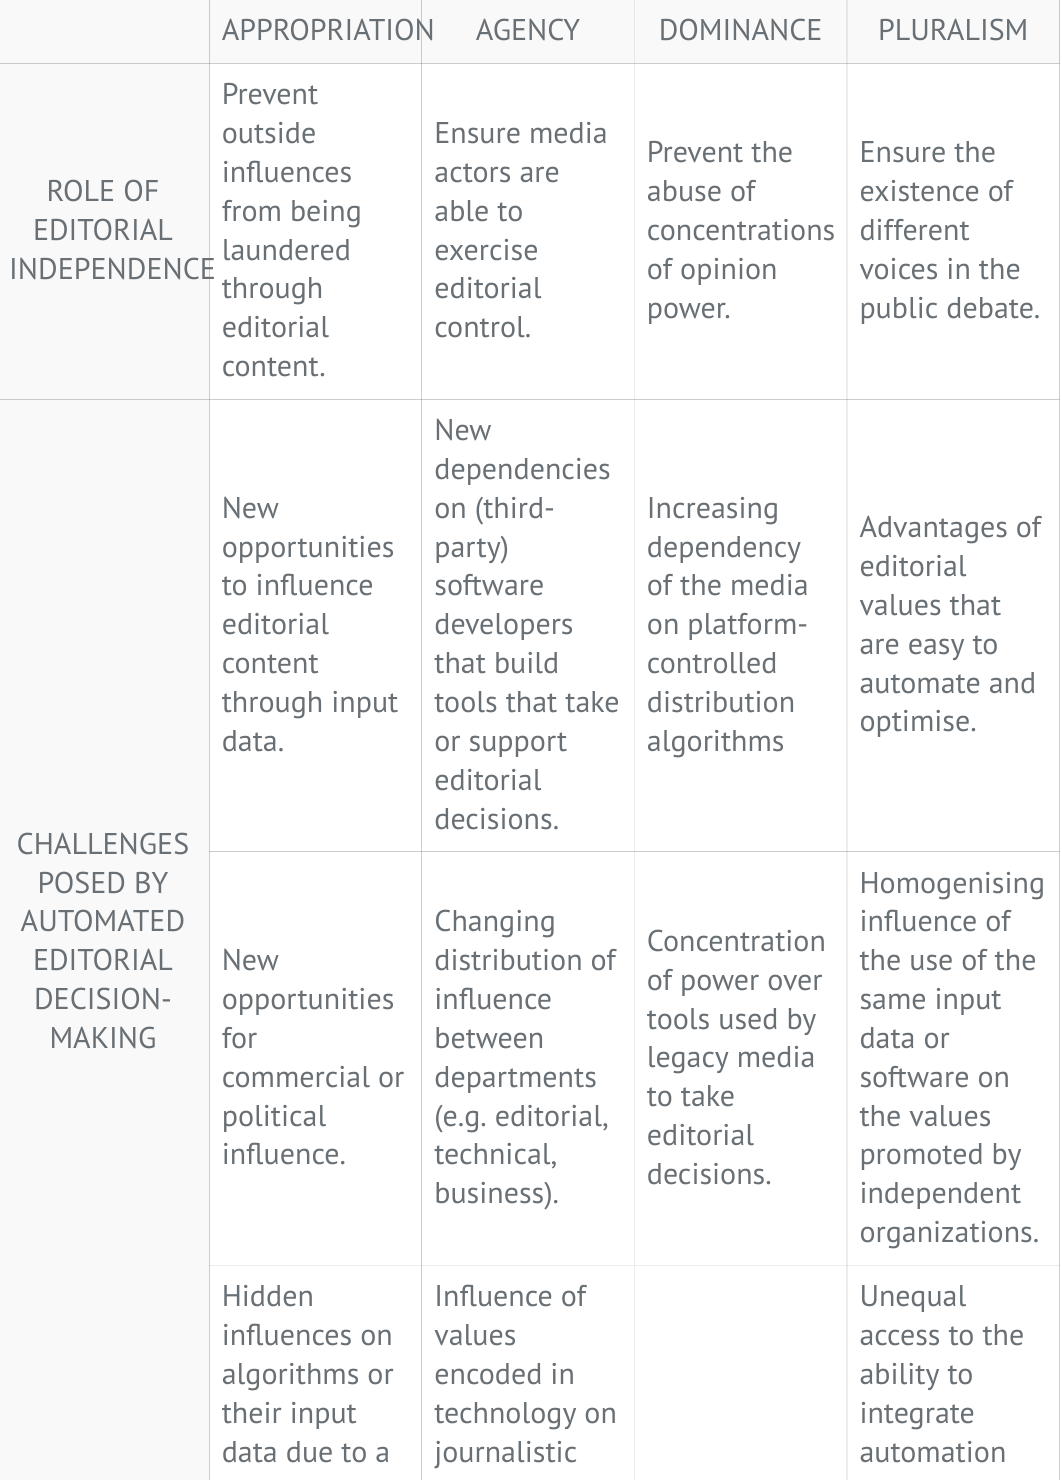
TABLE 1: Four perspectives on the changing role of editorial independence in the automated news system (source: elaborated by